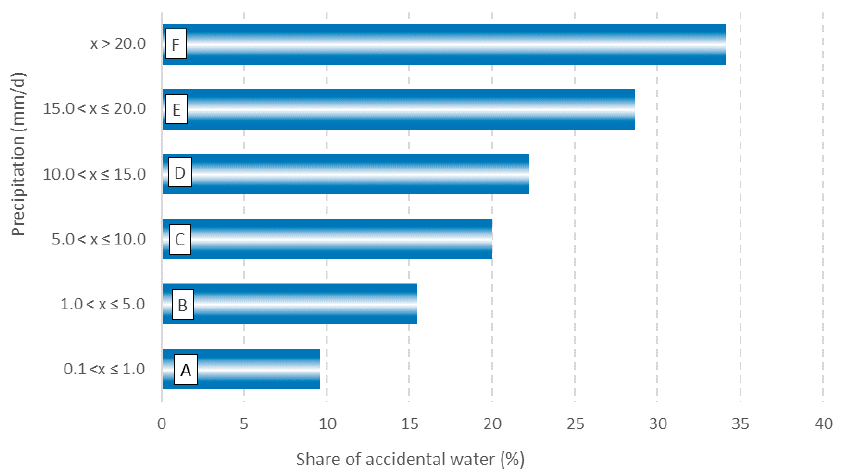
Figure 5. Percentage share of accidental water in the total amount of wastewater flowing into the wastewater treatment plant in Nowy Targ against the background of characteristic precipitation events.